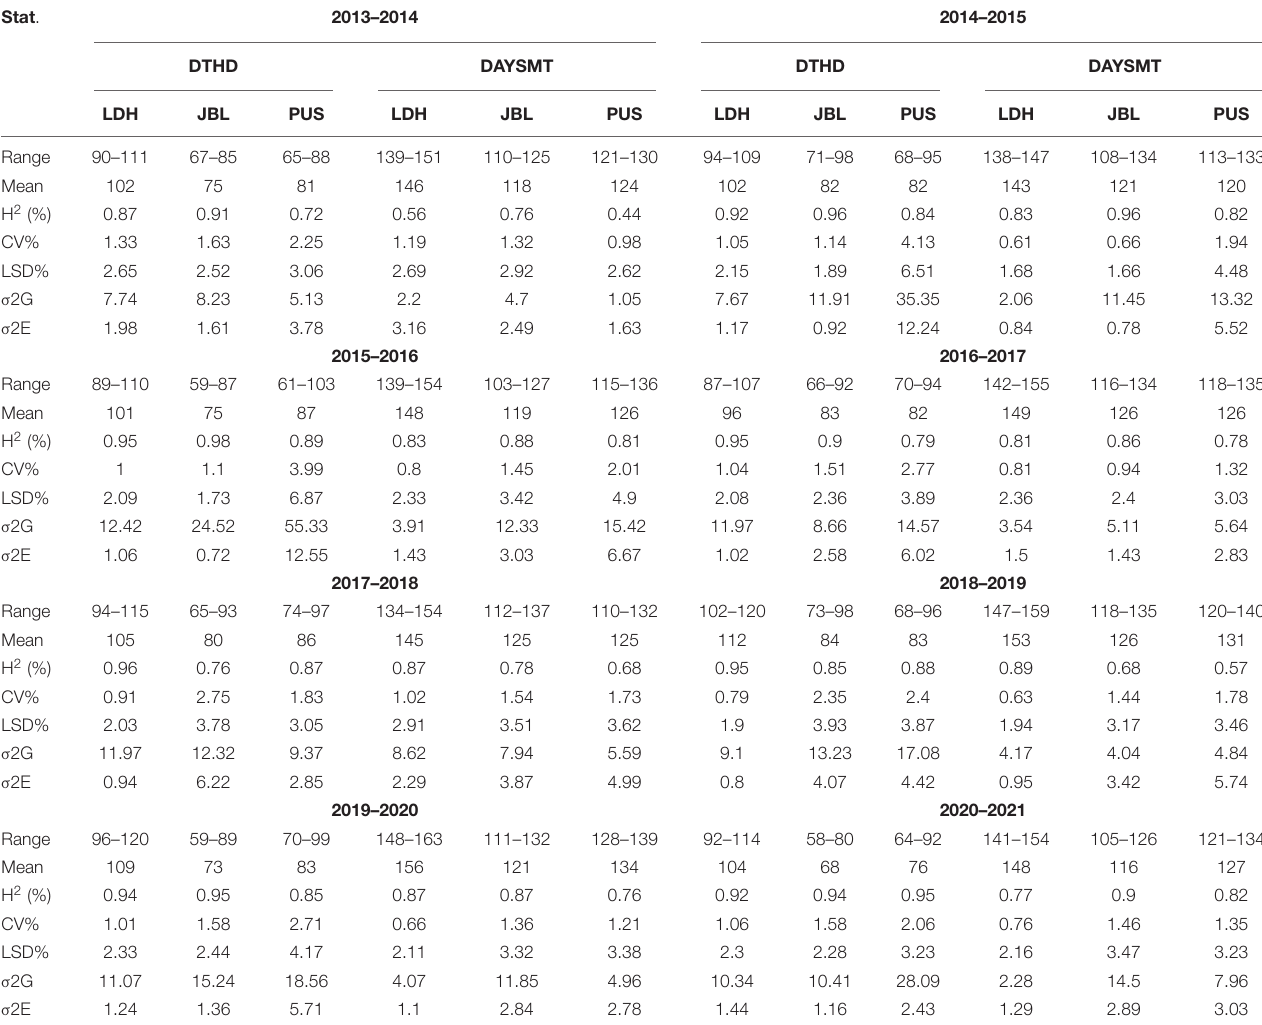
TABLE 1 | Descriptive statistics and variance parameters estimated for days to heading (DH) and maturity (DM) agronomic traits based on best linear unbiased estimate (BLUE) values in association panel grown at three different environments in India from 2014 to 2021. Stat